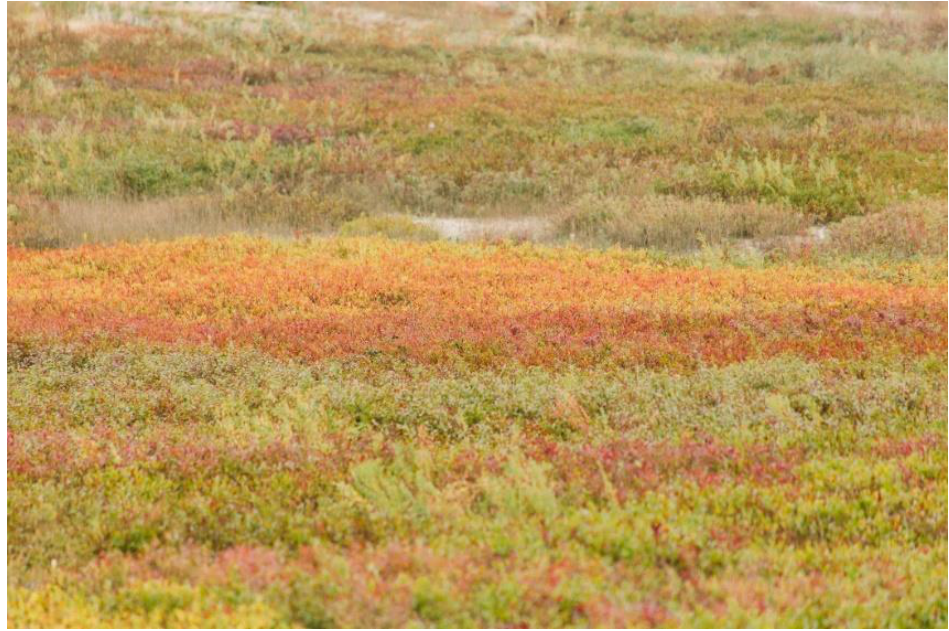
Figure 1. High crop morphological diversity of a wild blueberry field at the Blueberry Hill Research Farm in Jonesboro, Maine USA. Different genotypes were indicated by phenotypic differences in leaf and stem colours. Photo credit: Xiaoxue Mo.